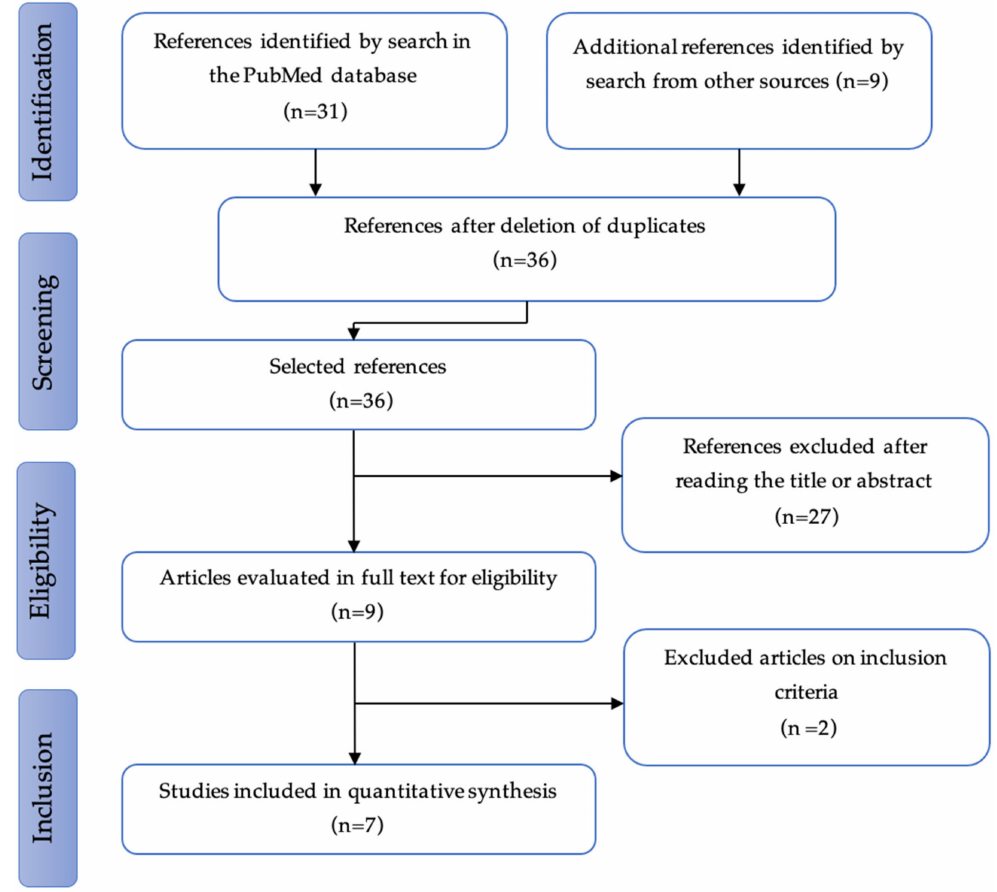
Figure 1. PRISMA flow diagram.